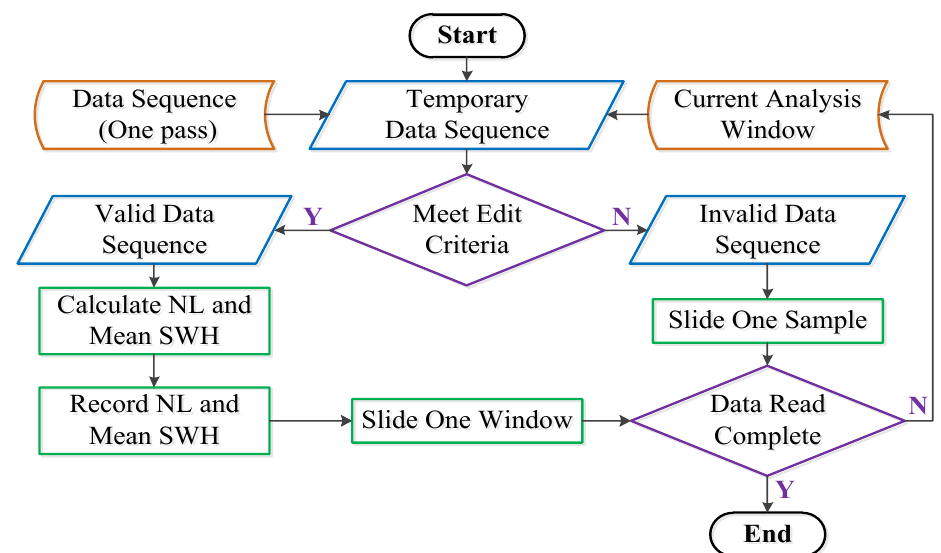
Figure 4. The data processing flow for estimating the noise level of the satellite